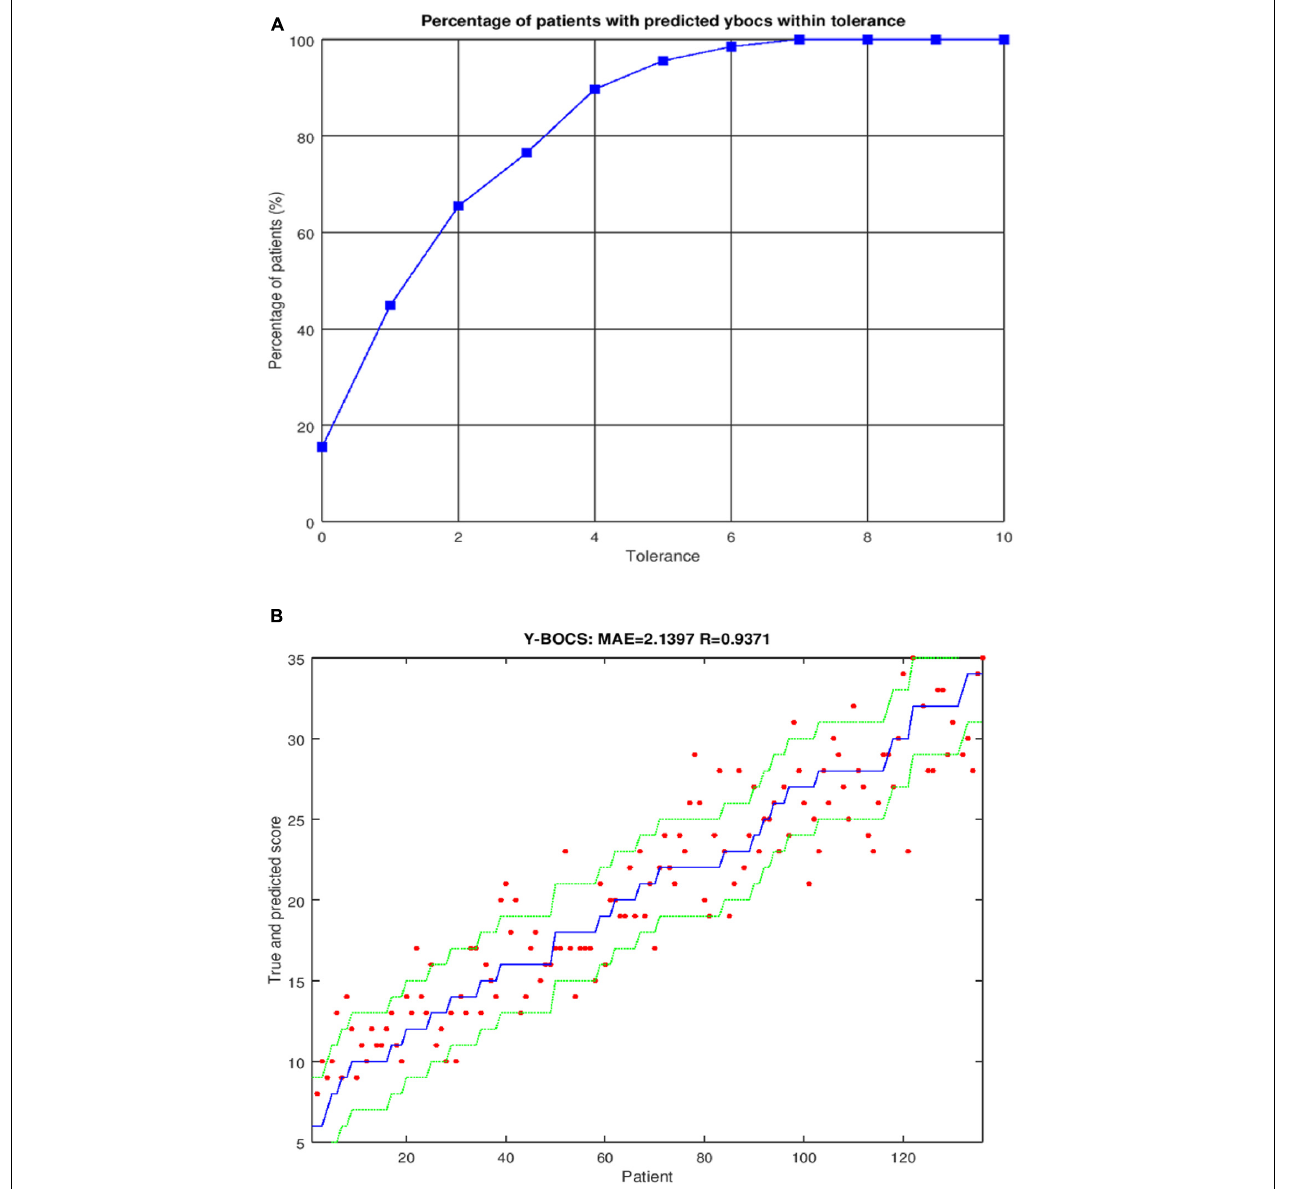
FIGURE 2 | (A) Graphical representation of self-perceived depression using the regressor SVR. Correct classifications were obtained for different tolerances: for t = 0, 26.52% of the patients were correctly classified; for t = 1, 57.58% were correctly classified; for t = 2, 80.30% were correctly classified; and for t = 3, 90.91% were correctly classified. (B) Graphical representation of self-perceived anxiety using the regressor SVR. Correct classifications were obtained for different tolerances: for t = 0, 21.97% of the patients were correctly classified; for t = 1, 43.94% were correctly classified; for t = 2, 70.45% were correctly classified; and for t = 3, 87.12% were correctly